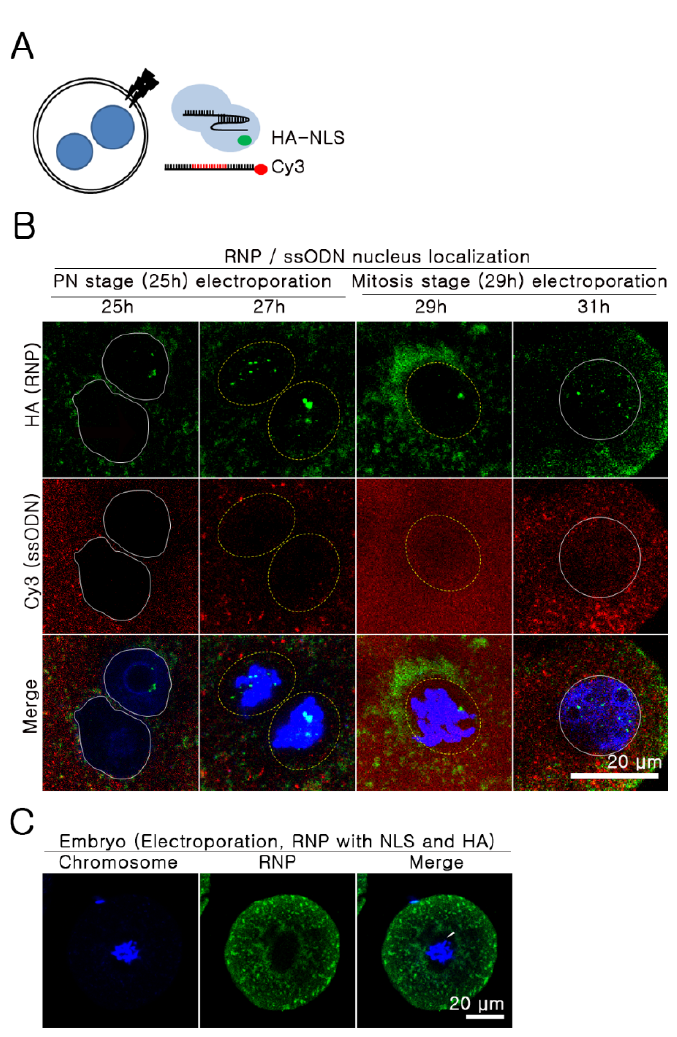
Figure 2. Nuclear localization of RNP and ssODN. ( A ) Experimental design. ( B ) RNP (HA-conjugated SpCas9 and sgRNAs targeting Rosa26 locus) and Cy-3-conjugated 100 bp-sized ssODN were electroporated into embryos at 25 h and 29 h after hCG injection. Next, half were immunostained with HA-Alexa 488 (green) mAb, and the other half were stained after two hours with the same target. Representative images are shown. The related videos are presented in Videos 1 and 2, Supplementary Materials. White solid line: intact nuclear membrane; white dotted line: disappeared nuclear membrane. ( C ) Physical barriers outside the chromosome (white arrow); blue: chromosome; red: ssODN; green: